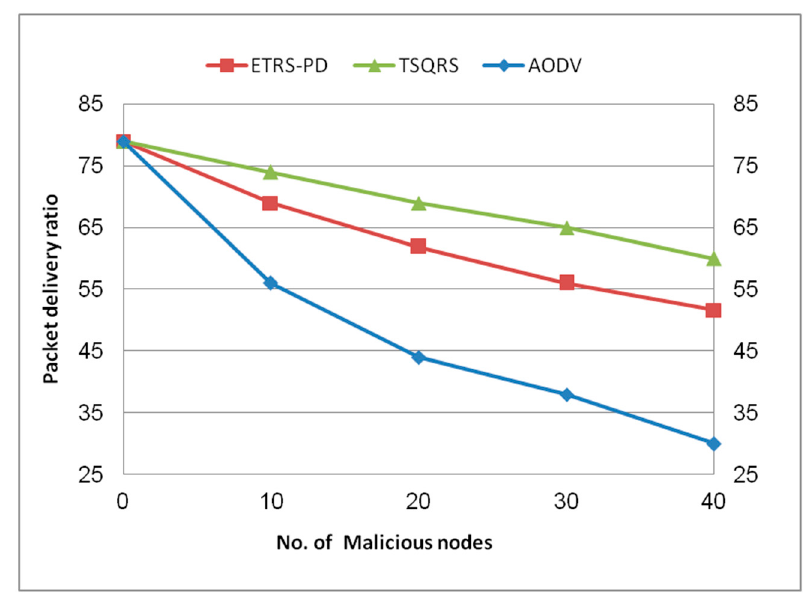
Figure 8. PDR against percentage of malicious nodes.